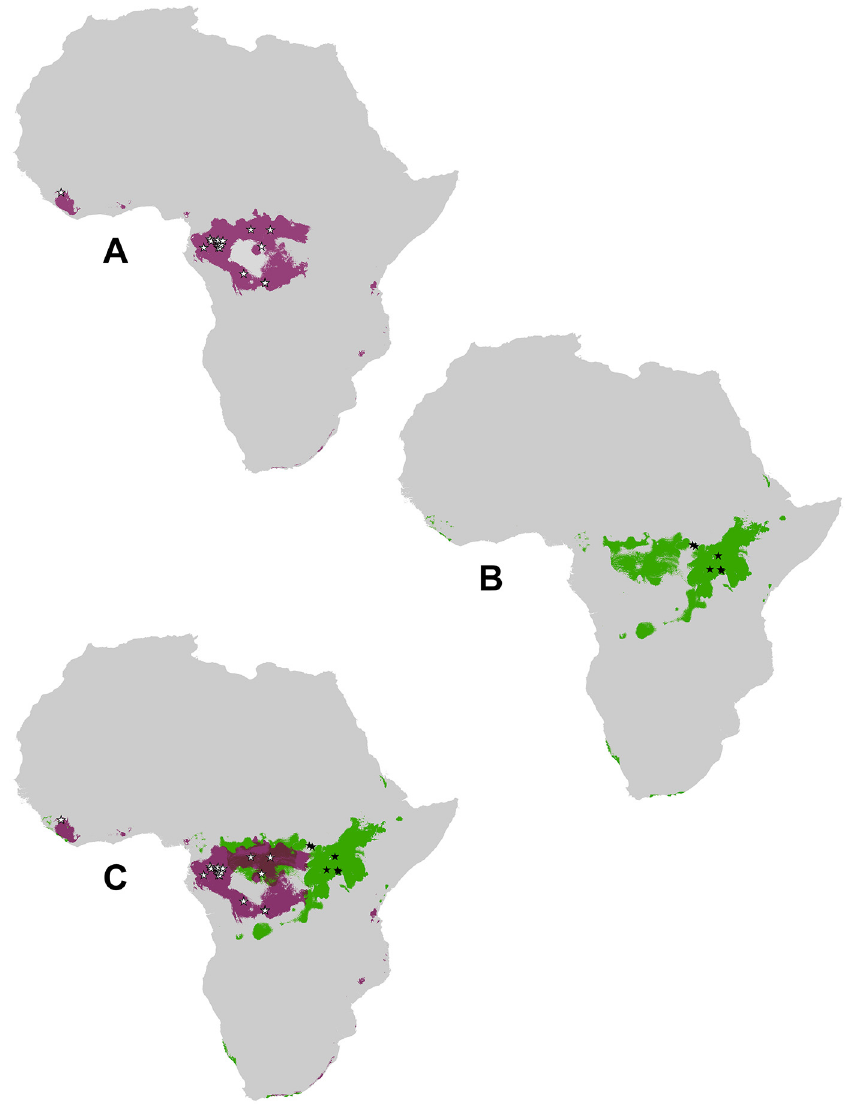
Fig 2. Suitable habitats for EBOV and SUDV spillovers events in mainland Africa. MaxEnt models with a minimum training presence threshold were used to determine the habitat suitability for EBOV and SUDV based on spillover locations. A) Purple represents EBOV model, and white stars indicate EBOV spillover locations. B) Green represents SUDV model, and black stars indicate SUDV spillover locations. C) Overlap of EBOV and SUDV models. See Fig A in S1 Text for global habitat